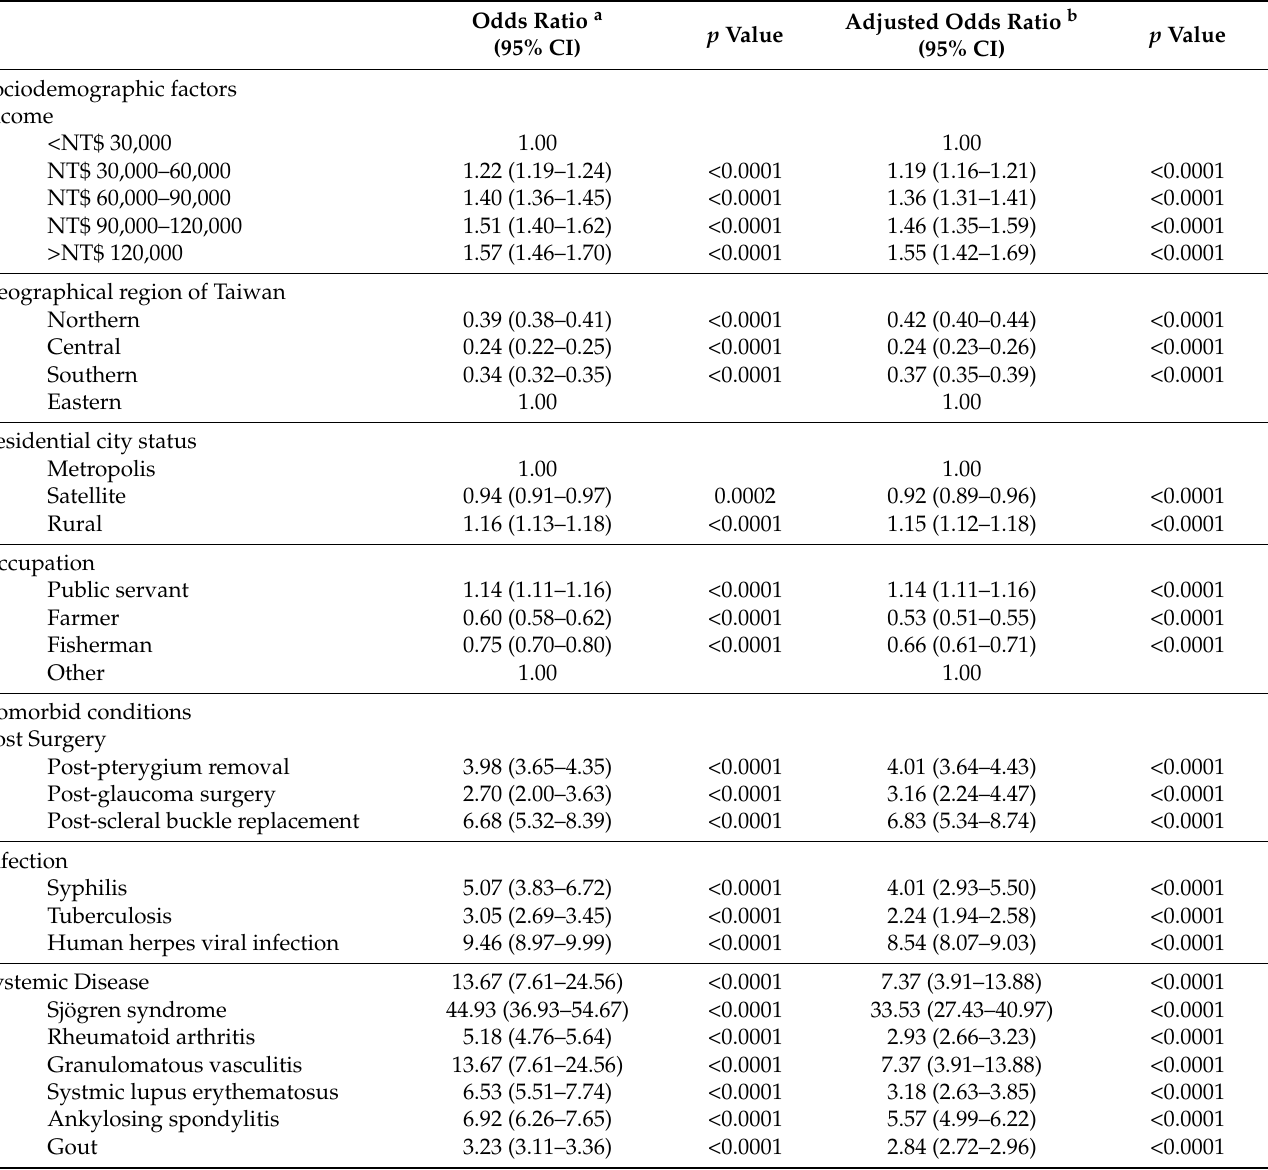
Table 2. Odds ratios and adjusted odds ratios for various sociodemographic factors and comorbid conditions with